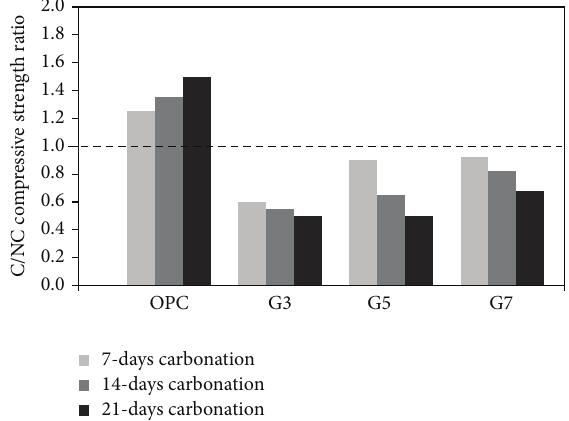
Figure 5: Ratio of the carbonation/noncarbonation (C/NC) com- pressive strength of the mortar.